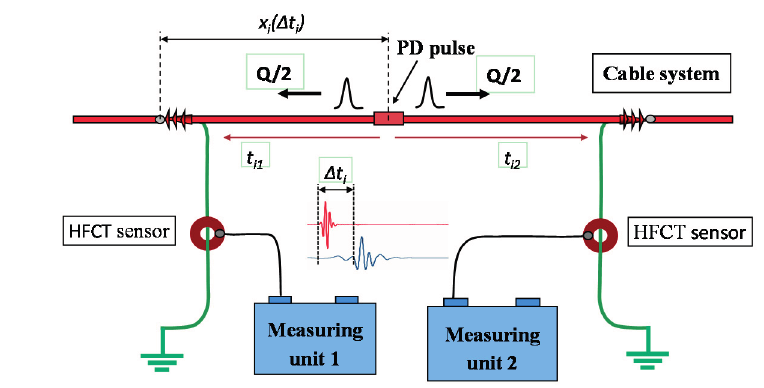
Figure 13. Time delay between the arrival times to the measuring